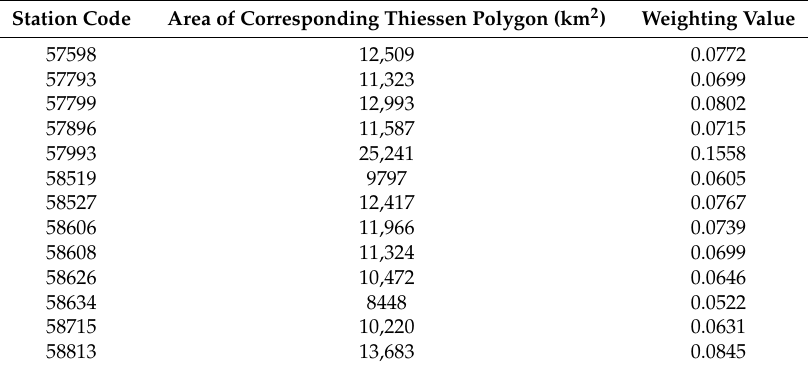
Table 2. Weighting values of selected meteorological